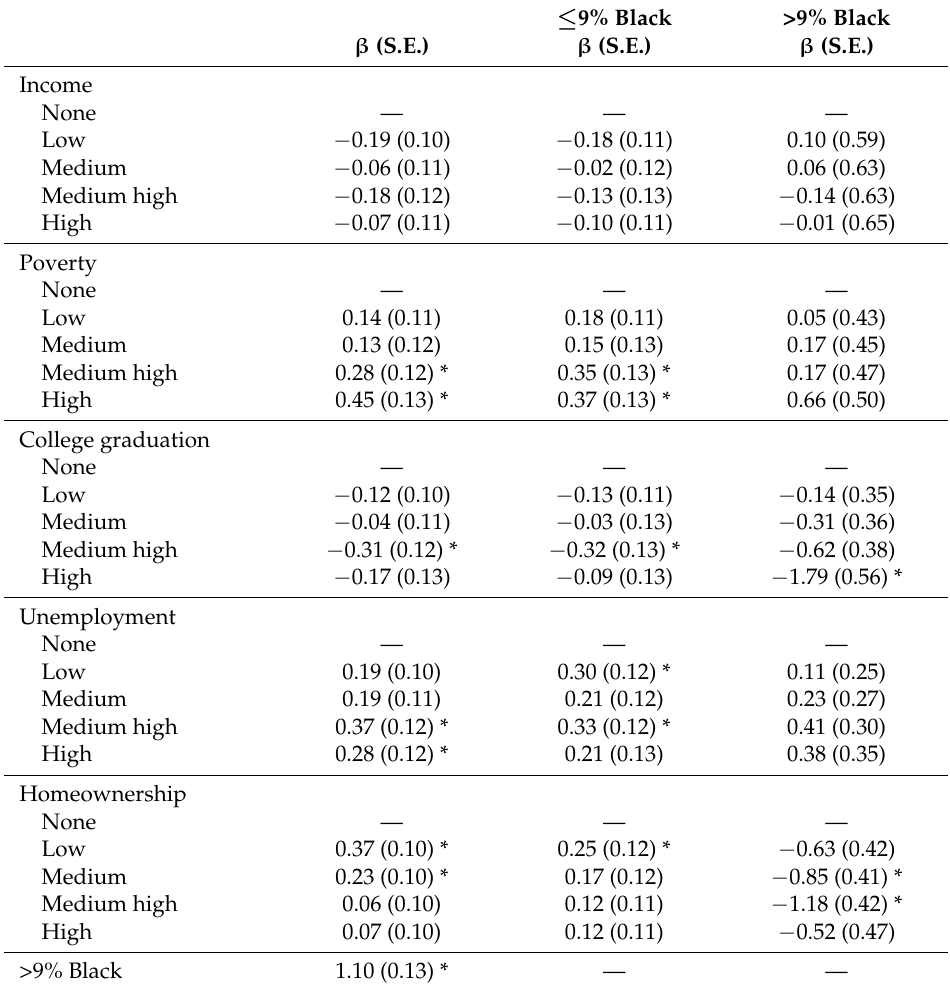
Table 2. Associations between indicators of structural racism and obesity by racial composition in U.S. county-years,